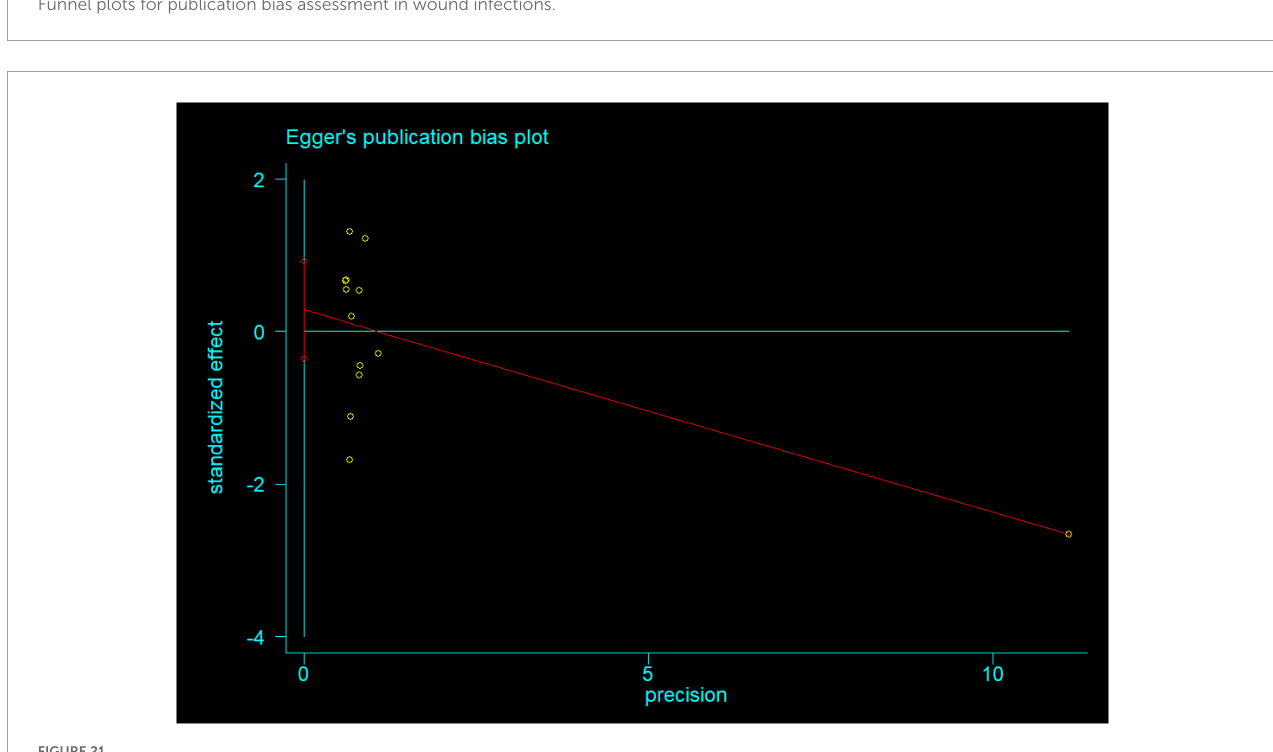
pulmonary embolisms, and lipid mediators are theorized to constitute its etiology. Moreover, physiological reactions and original pathological changes in patients are involved in its pathogenesis